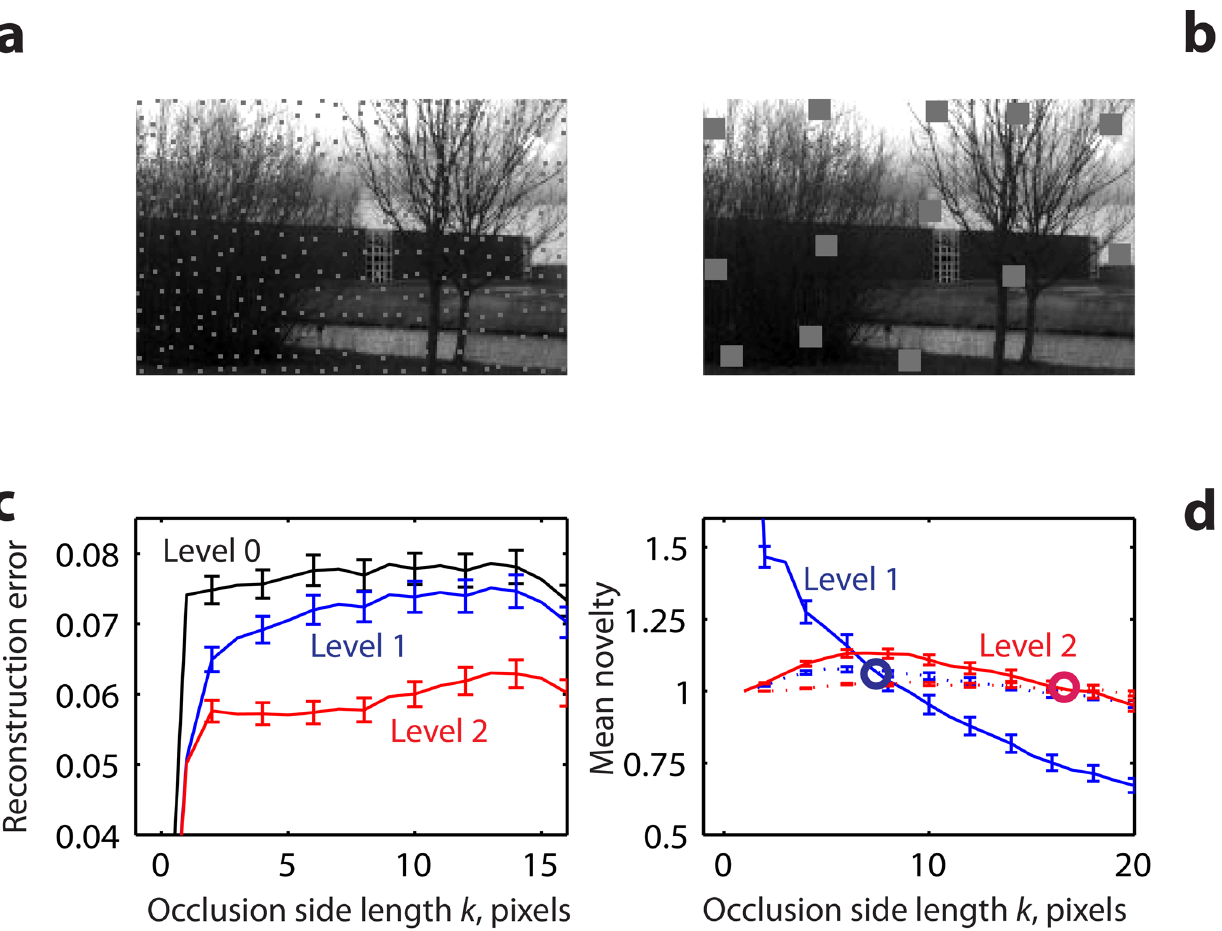
Fig 5. Reconstruction and novelty as a function of occlusion patch size k . a, b Example of a novel image with occlusion patches (grey squares) of side length k = 1 ( a ) and 10 pixels ( b ). For each patch size, the total occluded area is 5% of the image area. c Reconstructions of occluded and non-occluded images progressively become more similar across levels. Average distance δ (across 200 novel images) between the non-occluded original image I and the same image ^ I occluded by the patches (black curve, ‘ level 0 ’ ), and between the reconstructions of those images F − 1 ( I ) and F (cid:3) 1 ð ^ I Þ based on the familiarity neurons at level 1 (blue) and level 2 (red), respectively. d Average activity of level-1 (blue) and level-2 (red) novelty cells over the occluded (solid) and non- occluded image areas (dotted curves). Novelty neurons in the occluded parts of the image are more active than novelty neurons in the non-occluded parts of the image as long as the patch size k is smaller than the RF diameter (8 and 18 pixels for levels 1 and 2 — cf. blue and red circles — respectively).